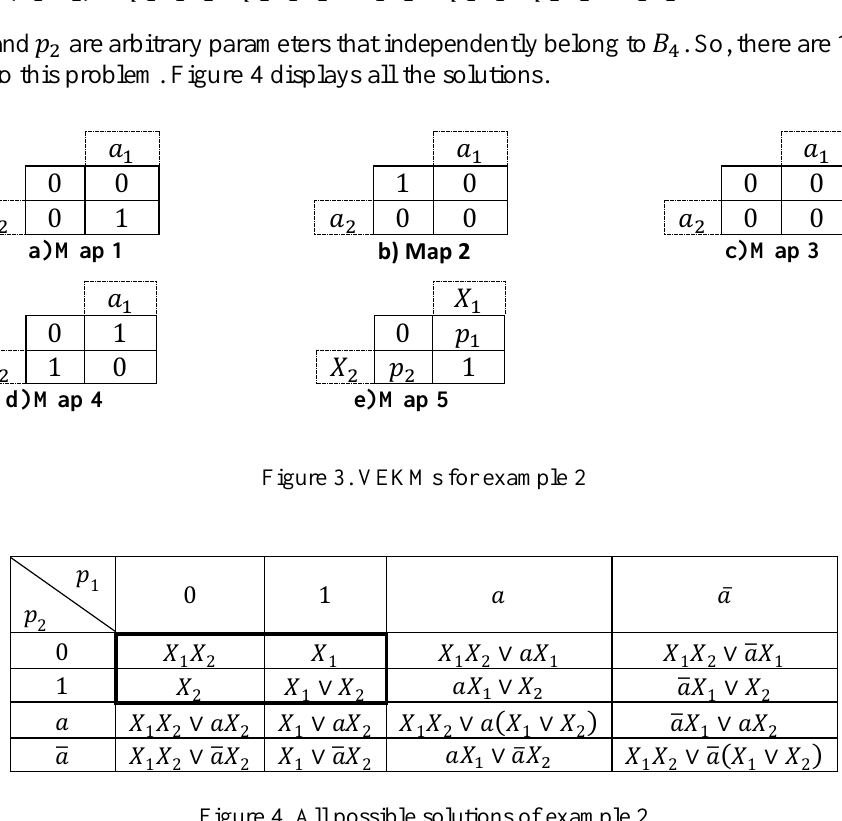
Figure 4. All possible solutions of example